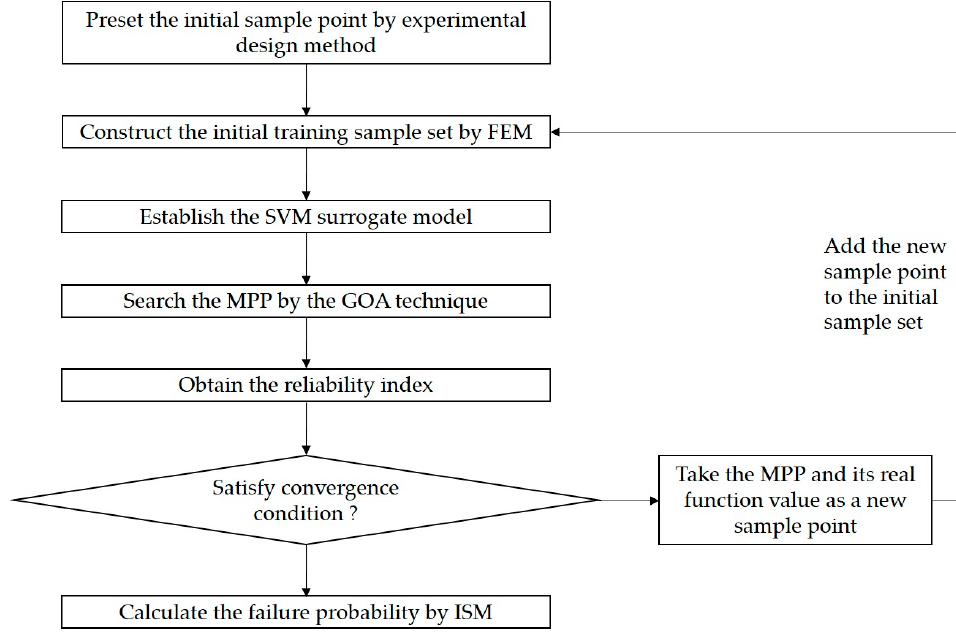
Figure 4. Flowchart of the SVM-based GOA method.